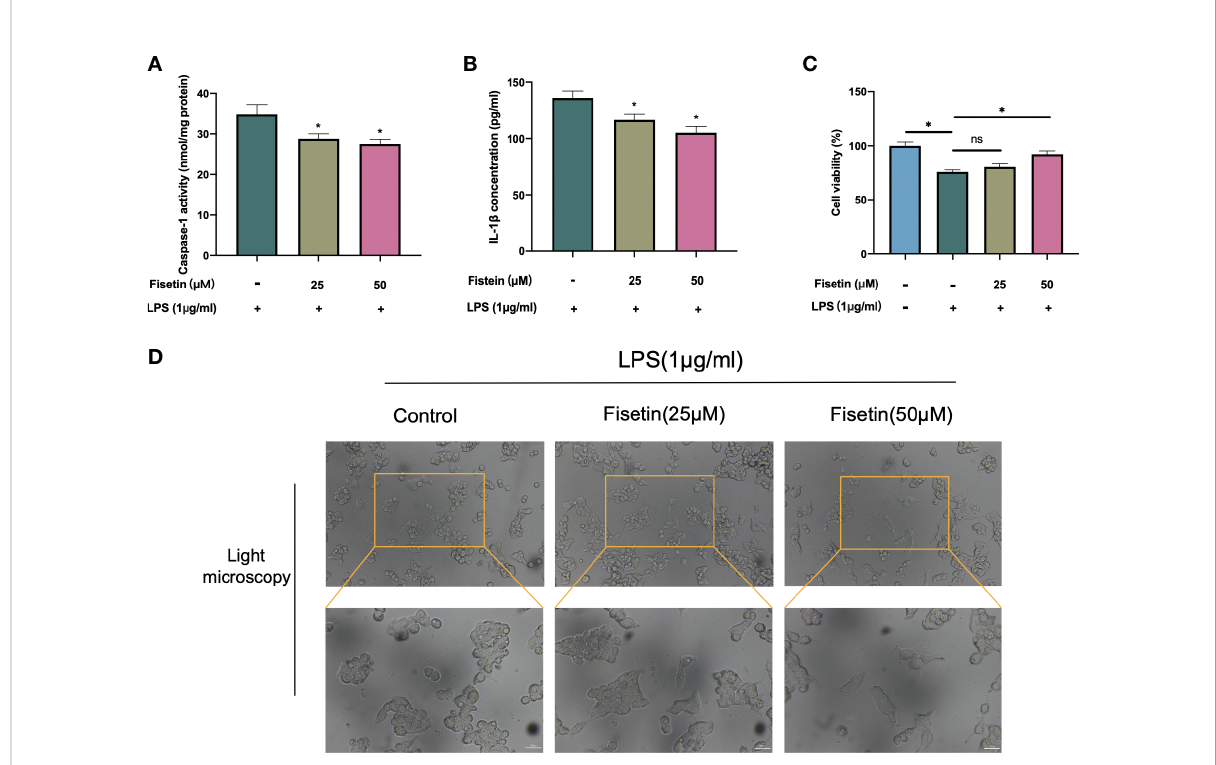
FIGURE 11 Fisetin inhibited NLRP3 in fl ammasome activation and alleviated HCC cell death. (A – C) HepG2 cells were treated with LPS(1 m g/ml) with or without fi setin at concentrations of 25 m M and 50 m M for 24 h, then the activity of caspase 1 (A) and IL-1 b level in supernatant of culture medium (B) were detected by ELISA, while cell viability was detected by CCK-8 assay (C) . (D) The morphology of the HepG2 was observed with a phase-contrast microscope. * P < 0.05 by ANOVA versus control. ns, not statistically signi fi cant; Scale bars: 50 m